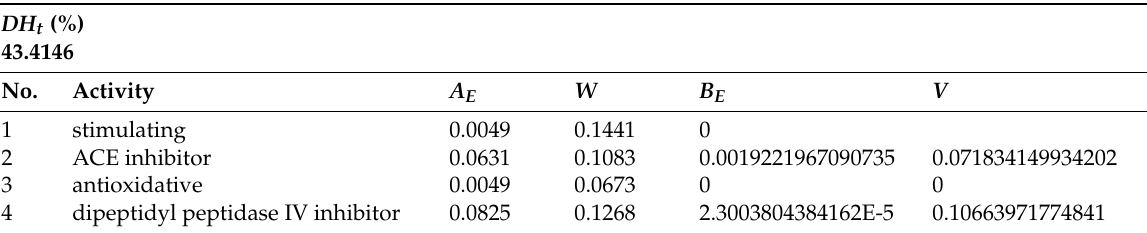
Table A28. A E , DH t , W , B E and V values from RubisCO of Halophila stipulacea . In silico enzymatic cleavage was carried out by using